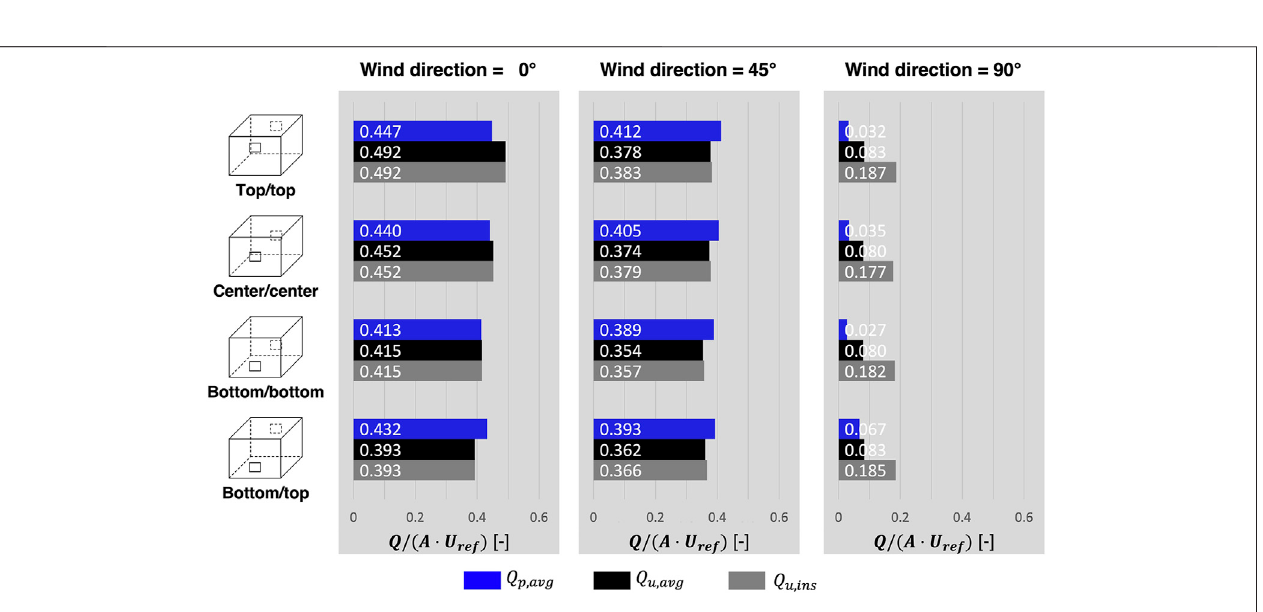
Frontiers in Built Environment |